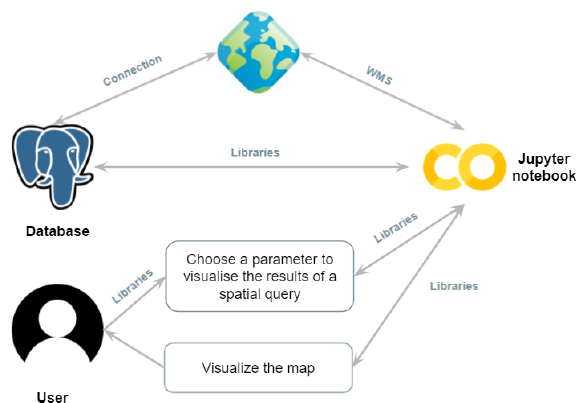
Figure 1 . The system architecture of MAPFOR